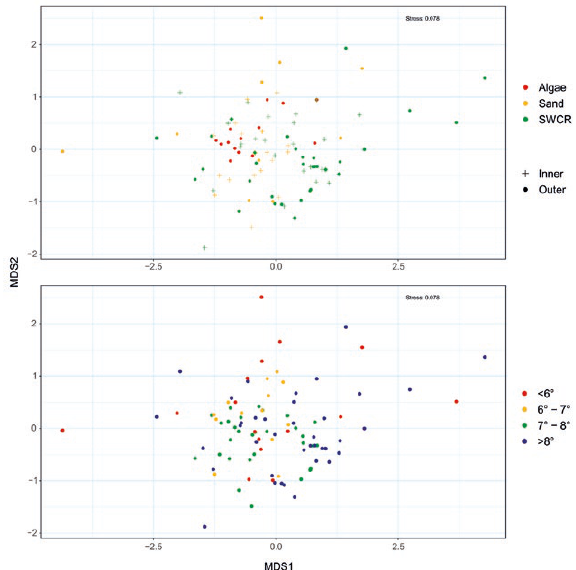
Fig. 7. – nMDS plot of the feed composition of P. maculatus in the different habitats (A - colours), shelf positions (A - shapes) at the different levels of latitude